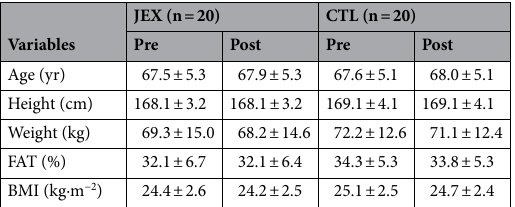
Table 1. Demographic and clinical characteristics. Values are means ± SD. JEX judo group, CTL control